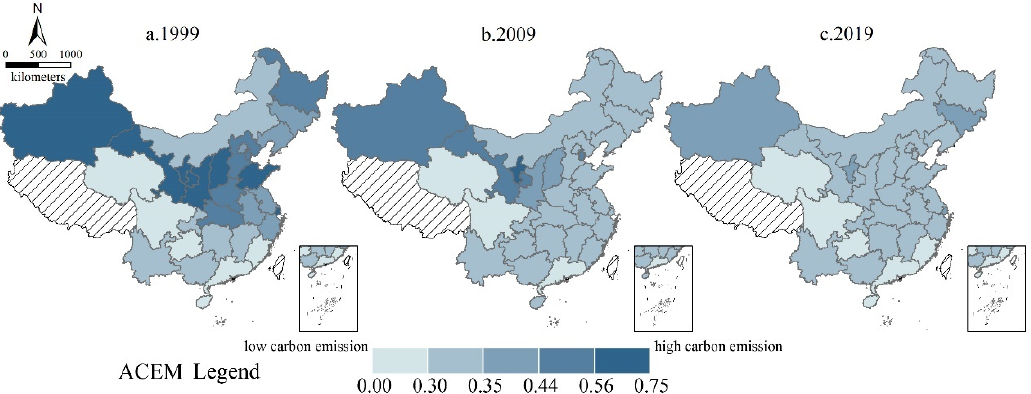
Figure 3. Spatial distribution of space utilization efficiency and carbon emissions: UCEF, APEF, UCEM, and ACEM are the urban construction efficiency, agricultural production efficiency, urban carbon emission intensity, and agricultural carbon emission intensity, respectively.